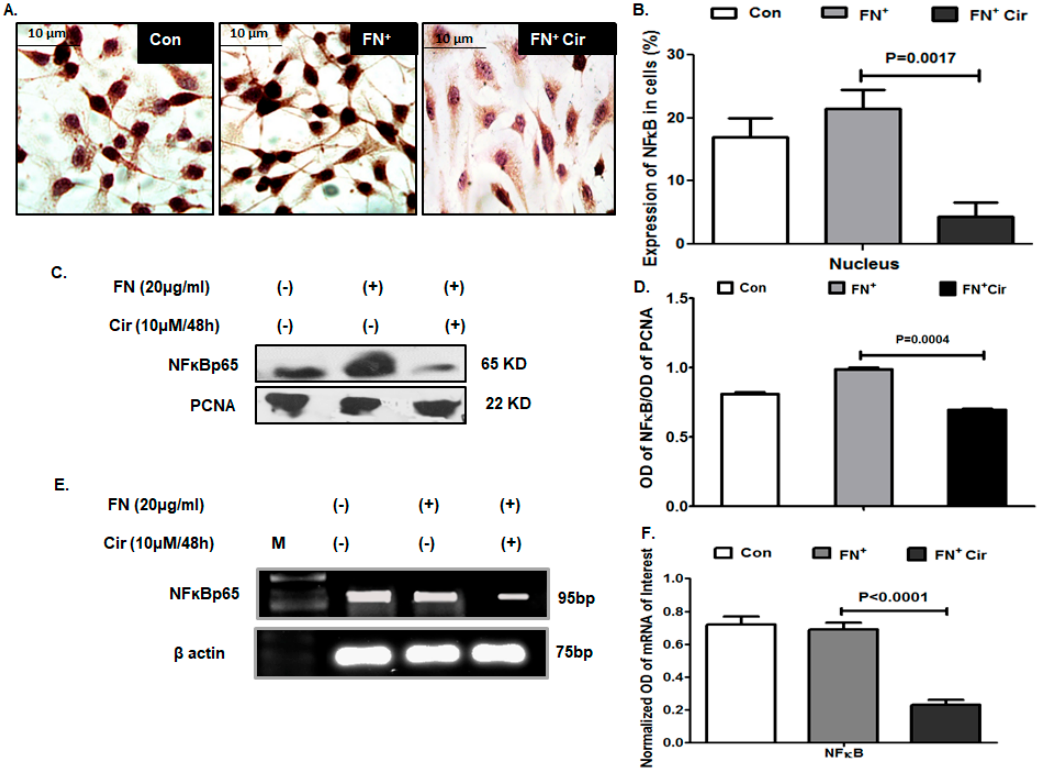
Figure 7. Effect of cirsiliol on NF- κ B signaling in B16F10 cells. ( A ) Micrographs of immunocytochemistry (400× magnification) exhibited reduced nuclear expression of NF- κ B p65 in FN + /Cir (10 µM/48 h) treated cells than the FN + -induced cells. ( B ) Quantitative analysis of cells with positive nuclear expression of NF- κ B p65. ( C ) Western blot images and ( D ) graphical representation of the normalized band intensities of nuclear NF- κ B p65 in FN + /Cir (10 µM/48 h) treated cells in comparison to FN + B16F10 cells. ( E ) mRNA images and ( F ) mean band intensities of mRNA of NF- κ B p65 in FN + /Cir (10 µM/48 h)-treated cells in comparison to FN + B16F10 cells. Cir: cirsiliol; FN + : cells were seeded in pre-coated (cellular FN 20 µg/mL for 2 h at 37 ° C) petri dishes and further incubated for 48 h in presence of 5% FBS for induction of EMT; FN + /Cir (10 µM/48 h): cells were seeded in pre-coated (cellular FN 20 µg/mL for 2h at 37 ° C) petri dishes and subjected to a non- cytotoxic dose of cirsiliol (10 µM) treatment for 48 h, M: DNA step ladder 100 bp. All quantitative results are expressed as mean±SD based on three replicates.